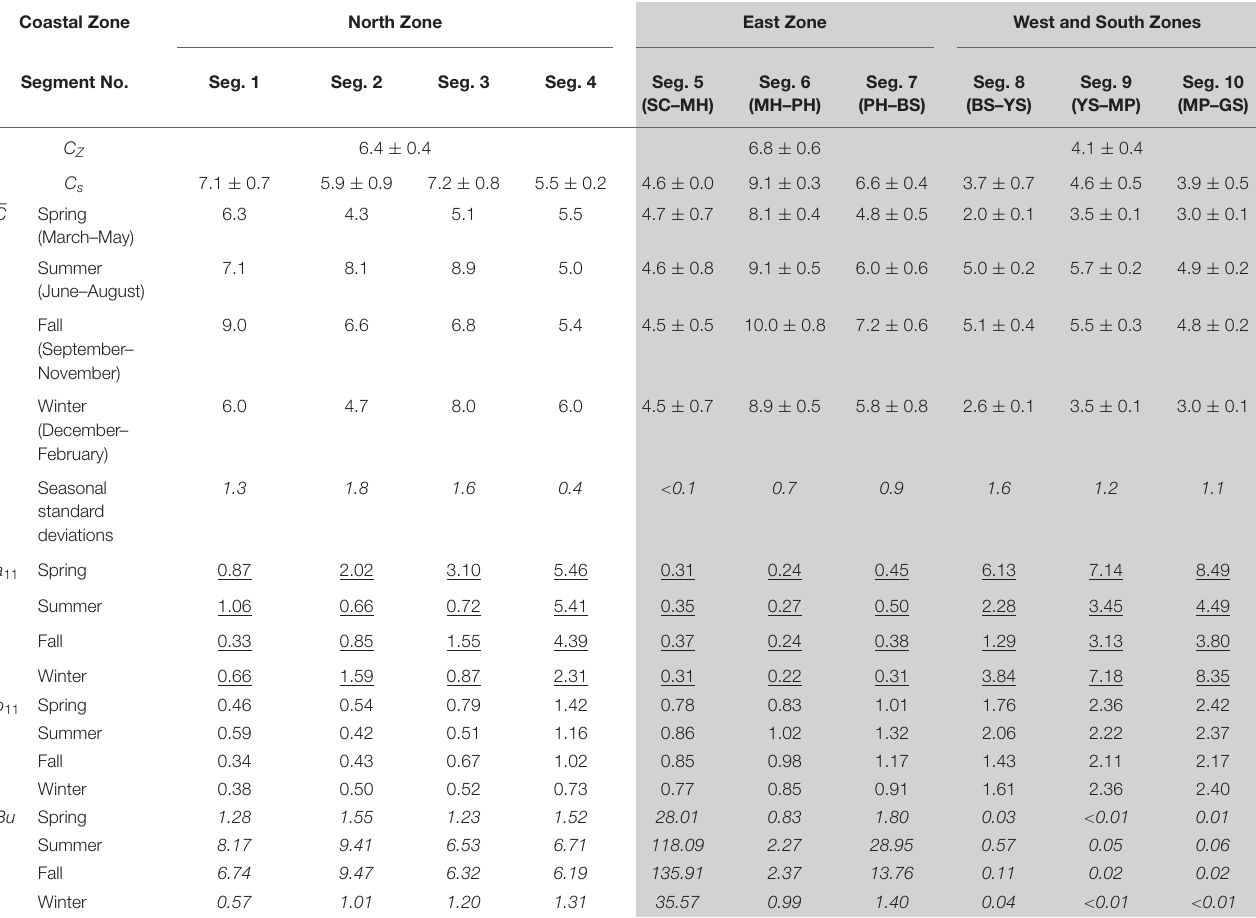
TABLE 2 | C z and C s of the modeled phase speeds (MPS, c 1 : m s − 1 ) of the first CTW mode ( n = 1) in three coastal zones (North Zone, East Zone, West and South zones collectively) and for ten segments (Segs. 1–10), and the (cid:83) C of the MPS, frictional decay coefficients ( a 11 : 10 − 9 cm − 1 ), and wind coupling coefficients ( b 1 : s 1 / 2 cm − 1 / 2 ) of the first CTW mode for four seasons (spring, summer, fall, and winter) and ten